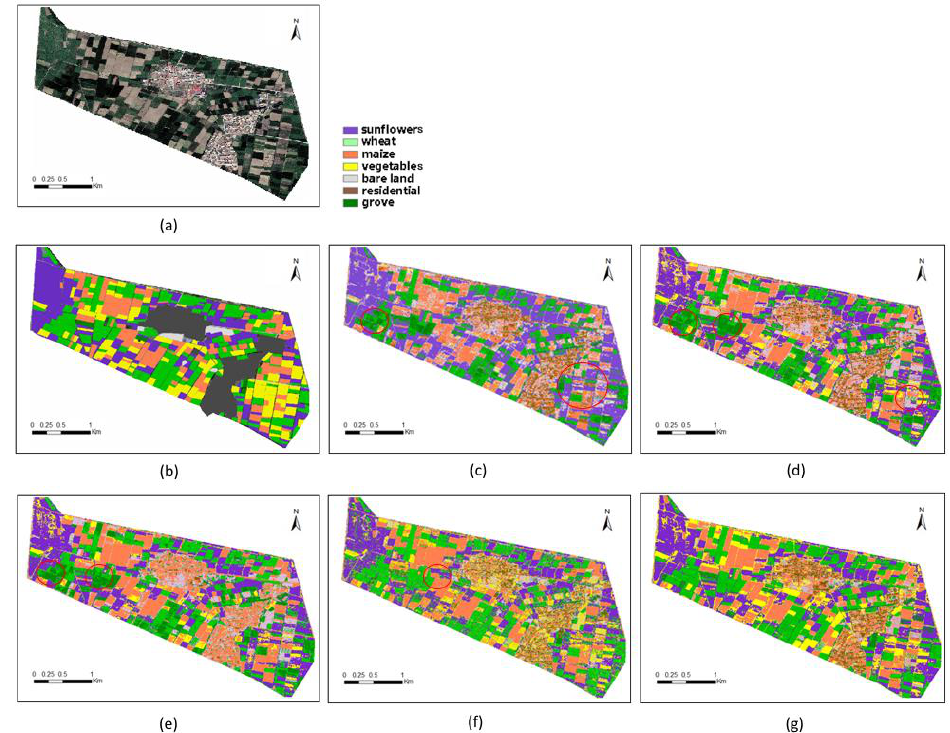
Figure 6. Comparison of the classification maps of experiment 4 using different algorithms, ( a ) original image, ( b ) handcrafted classified image, ( c ) RF classification results, ( d ) SVM classification results, ( e ) ELM classification results, ( f ) S-SVM classification results, and ( g ) SS-ELM classification results.